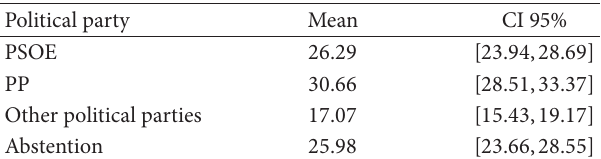
Table 5: Results (percentages) of the elections of Mar. 14 predicted by the model in case the Mar. 11 attacks had never